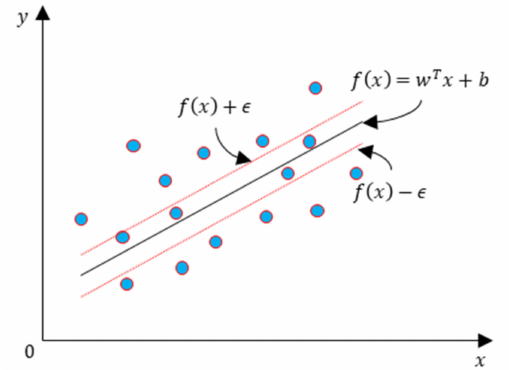
Figure 2. Support vector machine regression